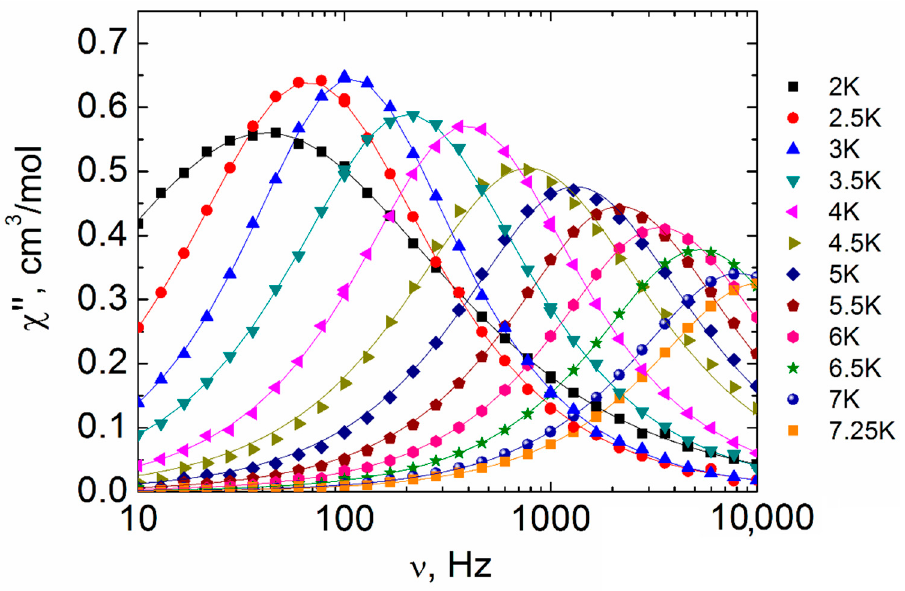
Figure 10. Frequency dependencies of the imaginary components of the ac-magnetic susceptibility for complex IX in the 2–7.25 K range taken under the optimal 1500 Oe dc-field. Solid lines represent fitting by the generalized Debye model.